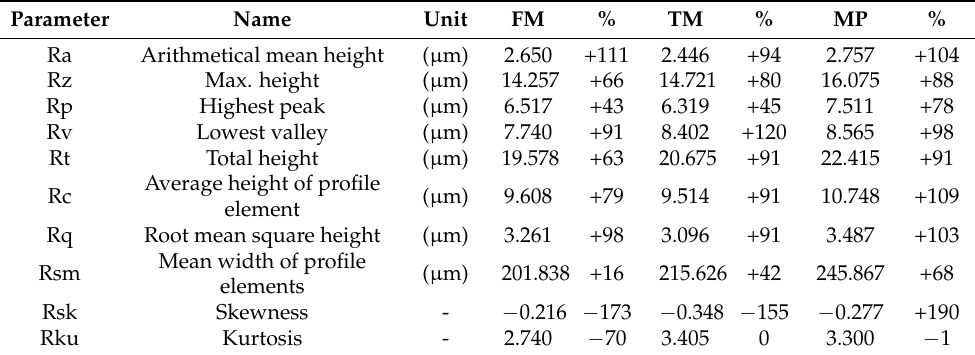
Figure 10. 3D surface roughness of the tested materials with P80 abrasives and 24.2 N load ( a ) unworn, ( b ) FM, ( c ) TM, ( d ) MP. Table 12. Surface characteristics after the wear tests (P80 with 24.2 N) and the change in